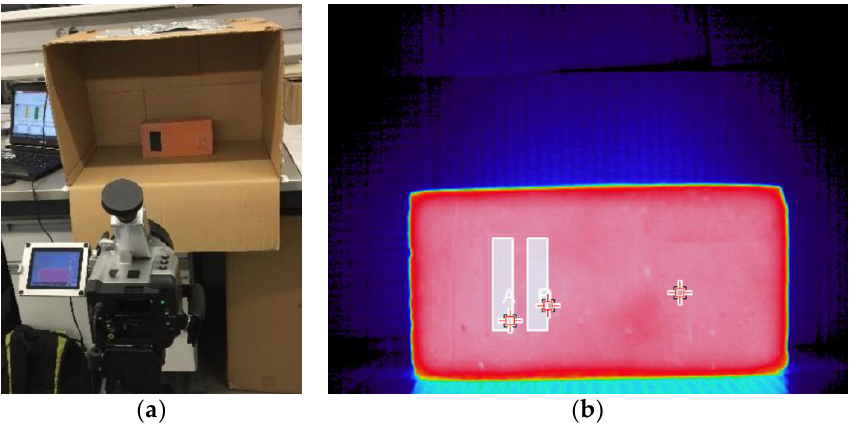
Figure 2. Infrared thermography (IRT). Test set up to assess the emissivity using IRT during tasks T.Ib and T.II: ( a ) measurement; ( b ) processing the measurement results. Table 1. Characteristics of the commercial tapes used in task T.Ia. Ref.